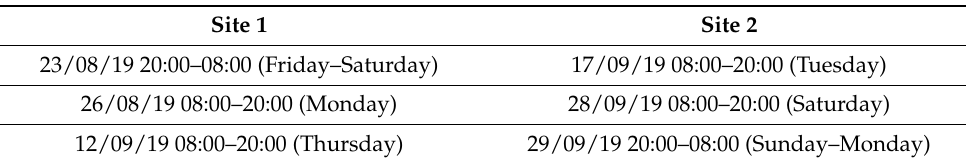
Table 1. Data Collection